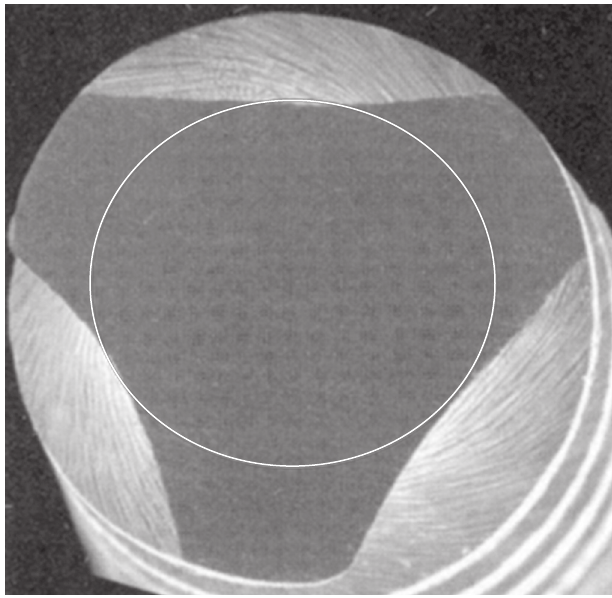
Figure 4. Representation of the ProFile instrument with triple U cross sec- tion (Lopes et al. 20 ).